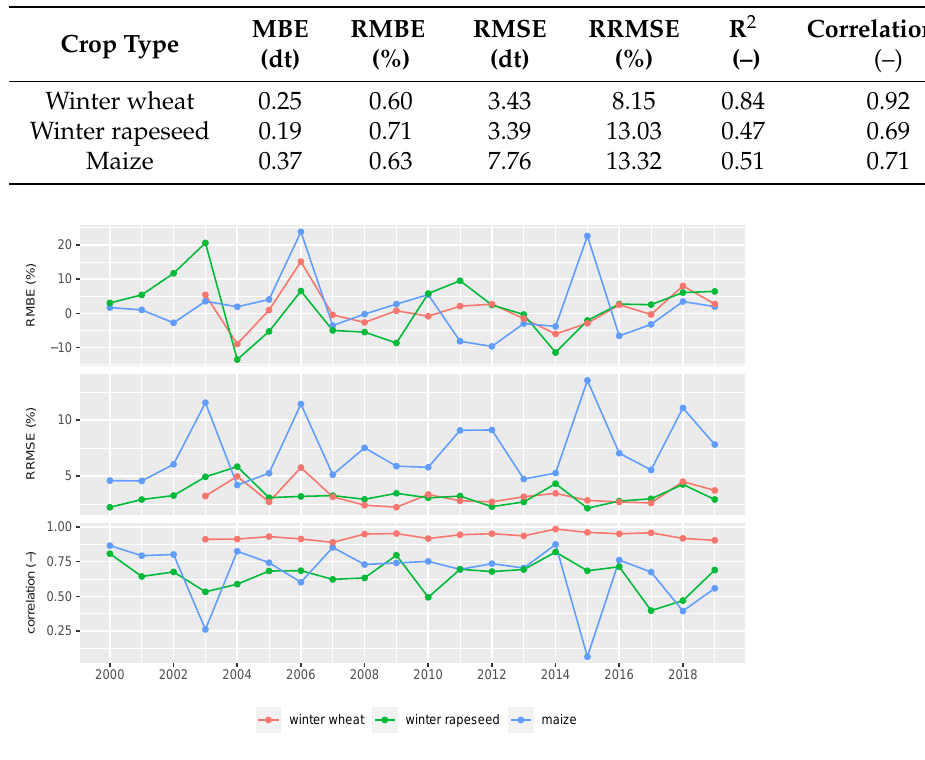
Figure 8. Time series of quality metrics of crop yield predictions for NUTS-2 units after the vegeta- tion